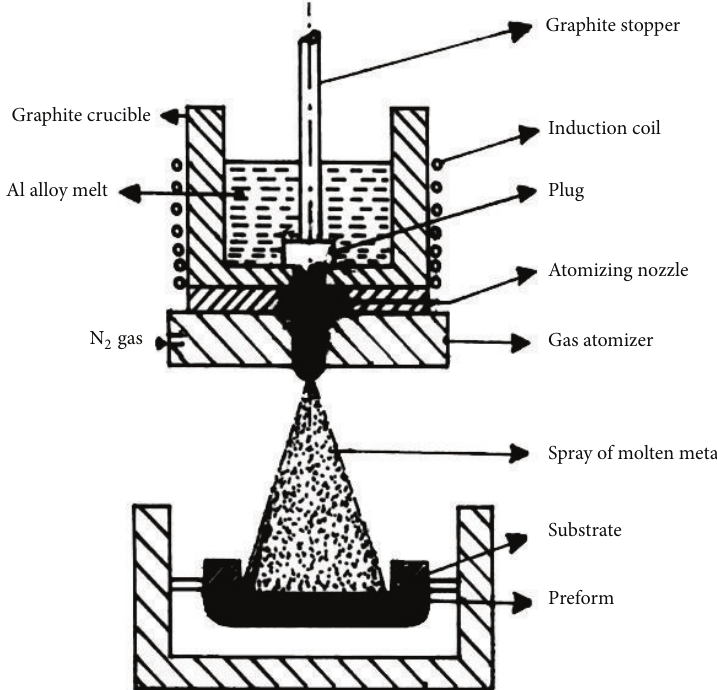
Figure 8: Schematic illustration of the experimental setup of spray forming [29].